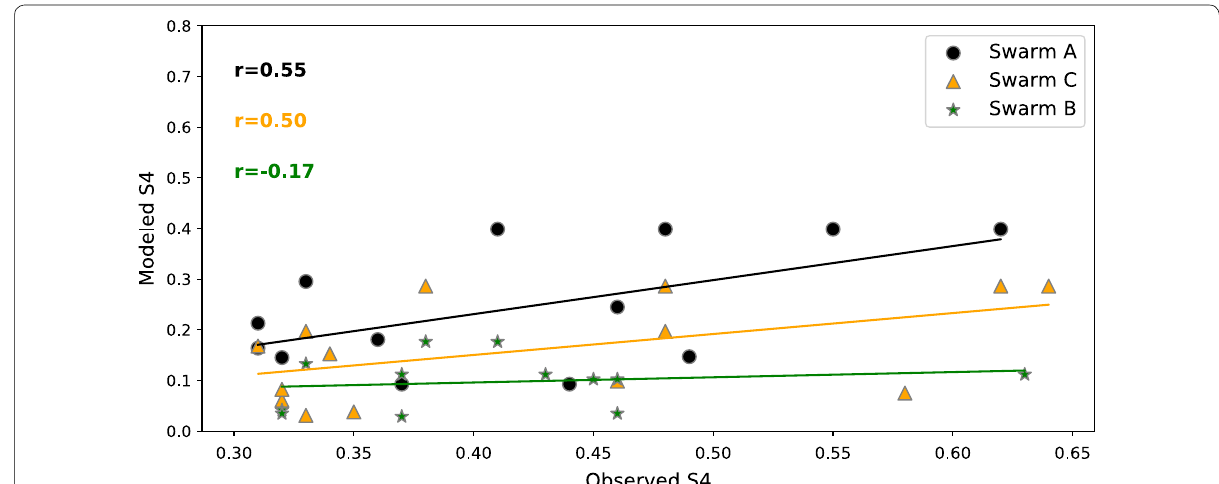
Fig. 12 Relation between the GPS-SCINDA measured S 4 index and modeled S 4 index for the years from 2014 to 2018. A best linear fit line is shown with the correlation coefficients, r given for each